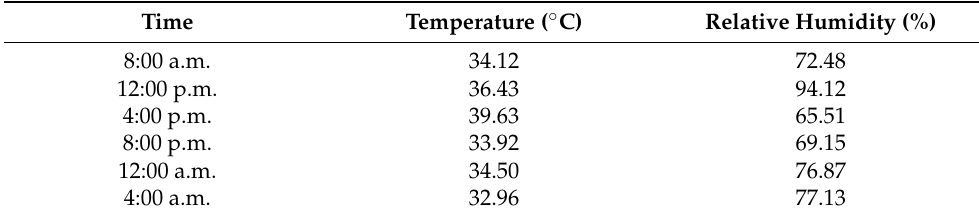
Table 2. Mean daily temperature and relative humidity of the experimental period.